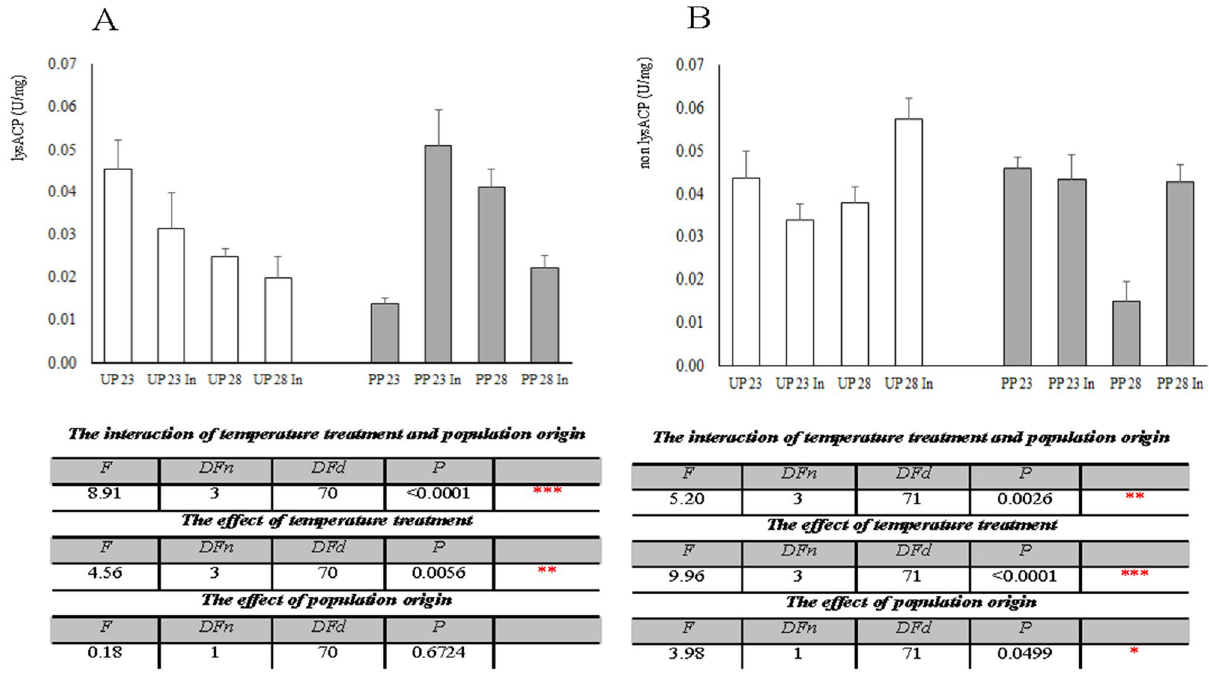
Figure 3. The specific activity of lysACP ( A ) and nonlysACP ( B ) in the midgut of 5th instar Lymantria dispar larvae exposed to different temperature treatments from unpolluted (UP groups) and polluted forest (PP groups); All abbreviations are the same as in Fig. 1. Significance of the effects of the thermal treatments, population origin, and their interaction on the variance of lysACP and nonlysACP activity with thermal treatments as fixed factor (two-way ANOVA, p ≤